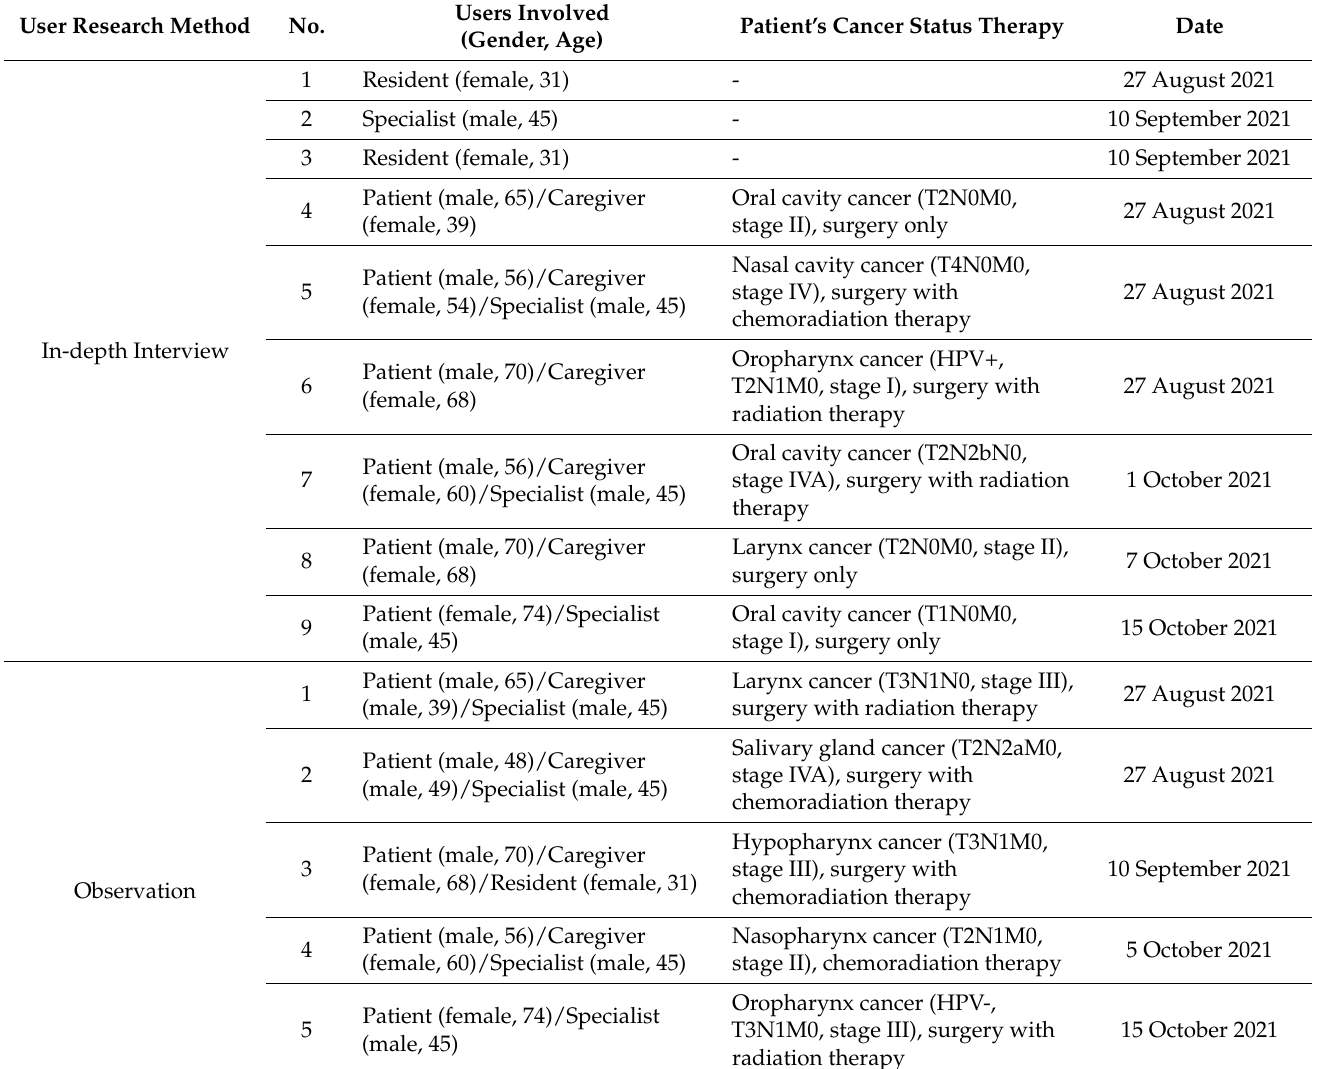
Table 1. The user research methods and users